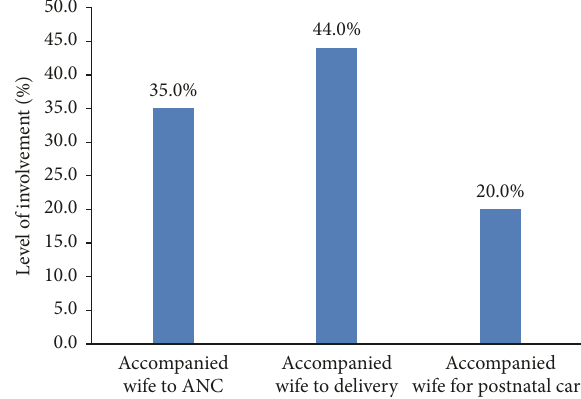
Figure 1: Level of male involvement in maternal health care ( 𝑁 = 100 ). Source: Fieldwork,